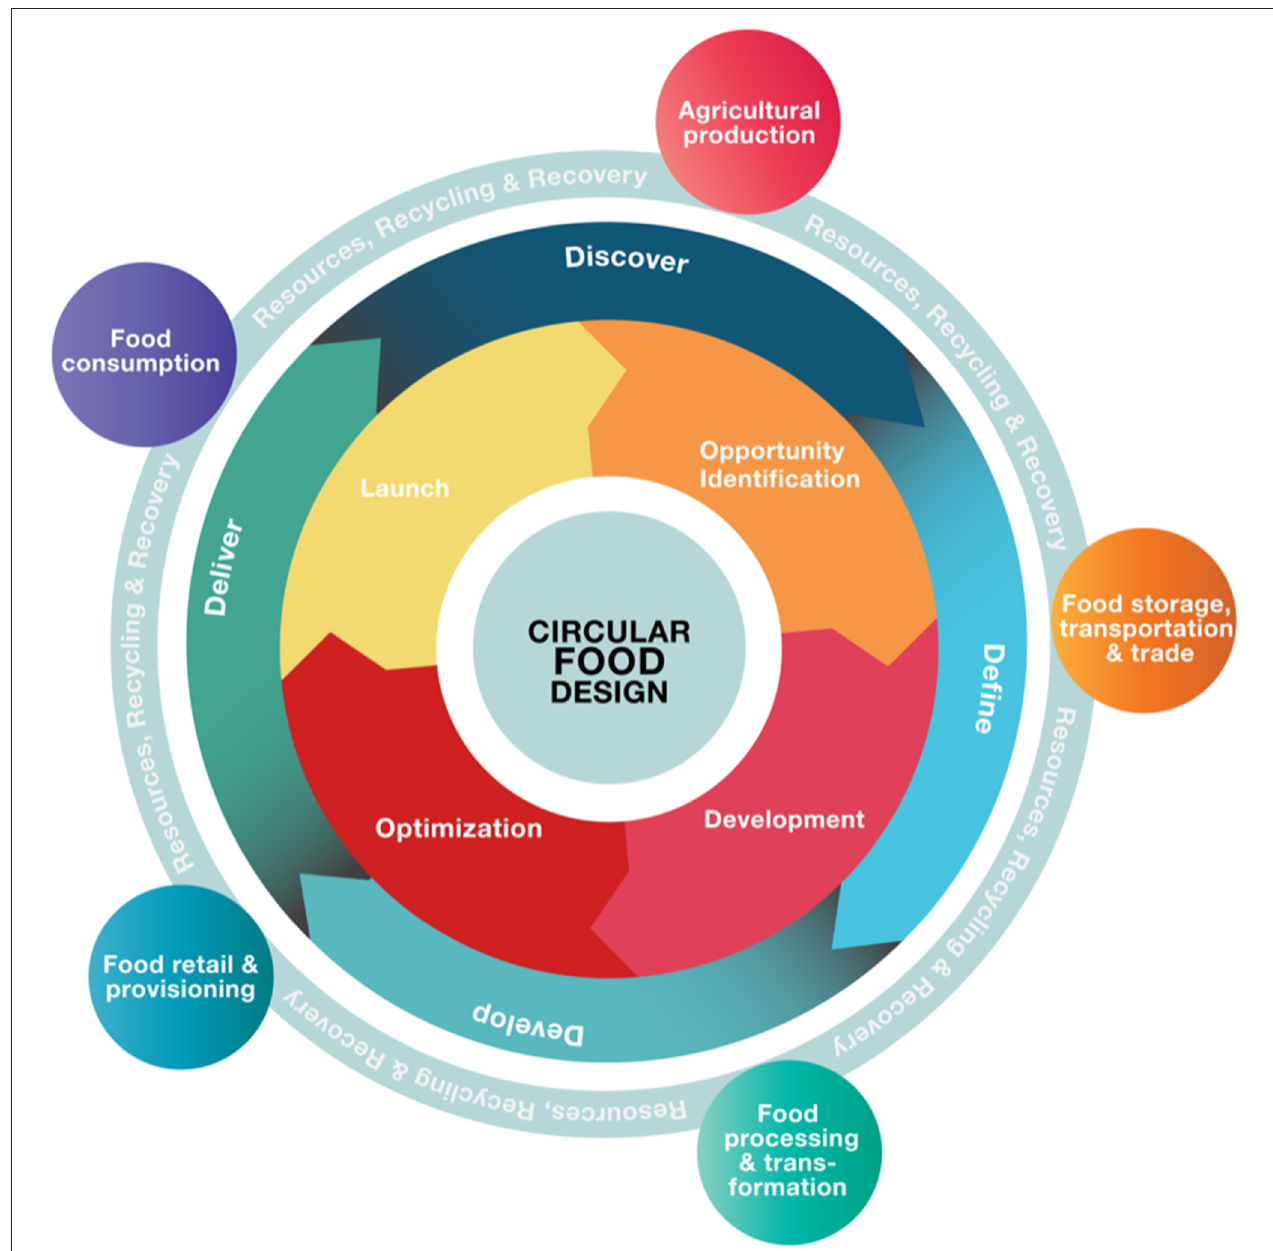
FIGURE 3 | Circular food design